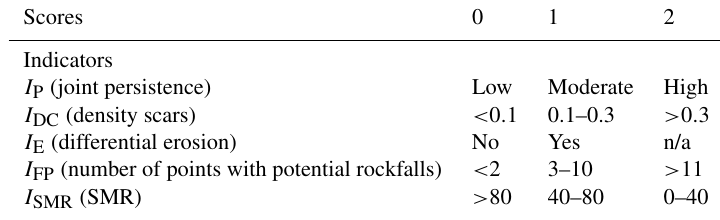
Table 3. Scoring of the geomorphological indicators used for the rockfall-frequency assessment. Scores 0